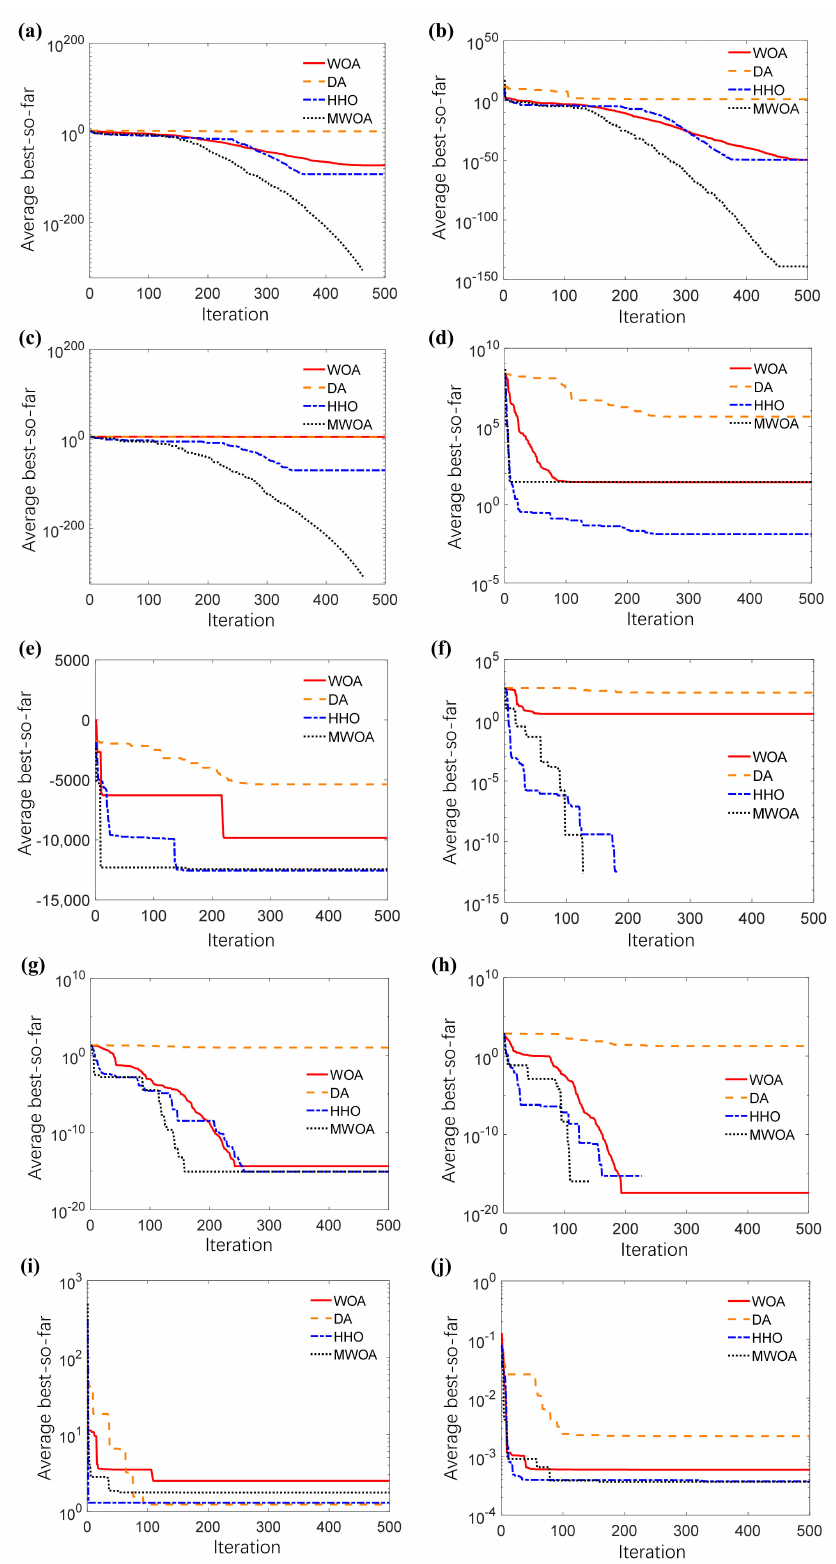
Figure A1. Convergence curves of four intelligent optimization algorithms. ( a ) Convergence curves for f 1 . ( b ) Convergence curves for f 2 . ( c ) Convergence curves for f 3 . ( d ) Convergence curves for f 4 . ( e ) Convergence curves for f 5 . ( f ) Convergence curves for f 6 . ( g ) Convergence curves for f 7 . ( h ) Convergence curves for f 8 . ( i ) Convergence curves for f 9 . ( j ) Convergence curves for f 10